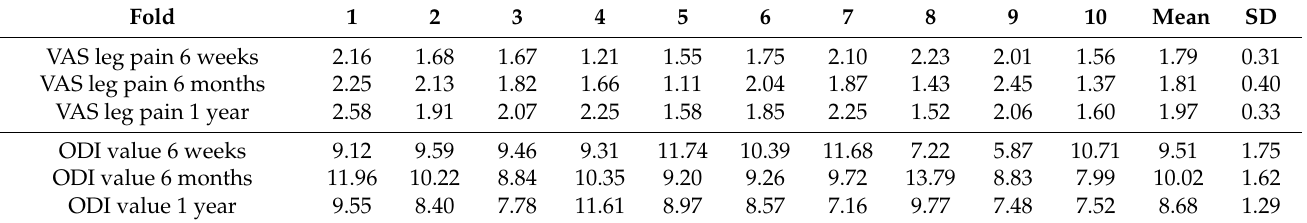
Table 6. Detailed mean absolute error of the performed 10-fold cross-validation for the prediction of each target value using our decision tree regressor